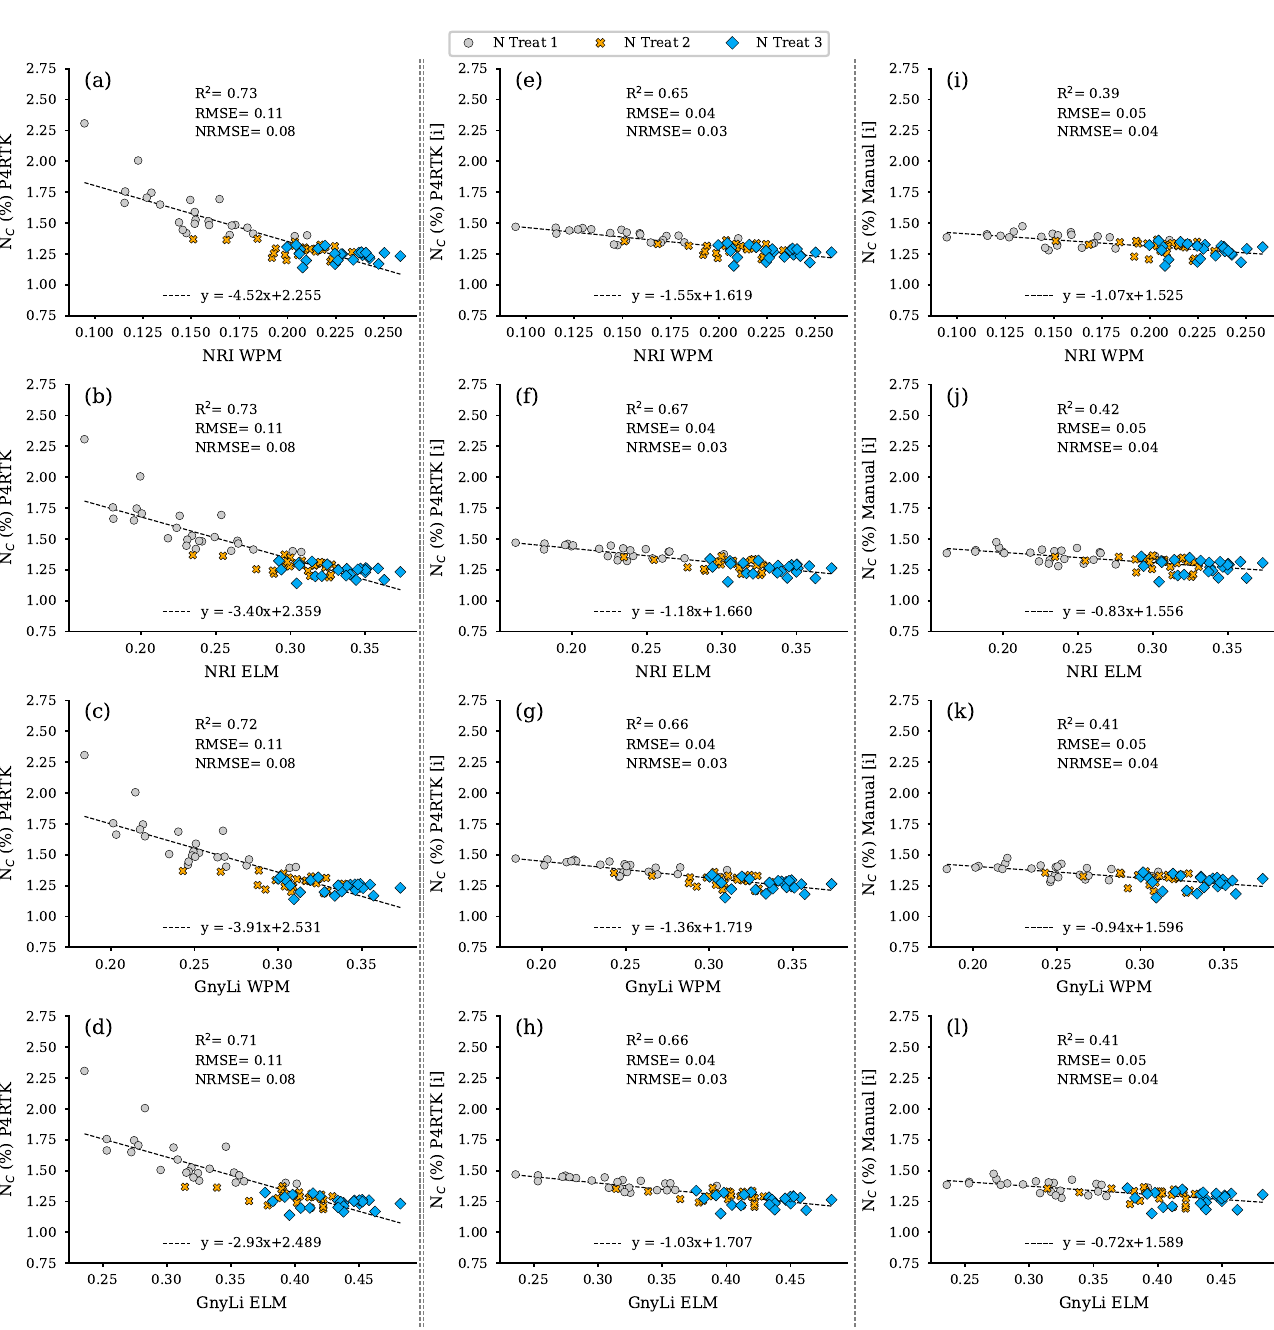
Figure 17. Scatter plots for the N concentration (N C ) data estimated for the 72 non-destructive test plots with the N C -model, based on the DBM estimator RM for three different CH data sets, with the spectral camera VIs acquired on 2 June. Left column: CH directly derived from P4RTK RGB data set of 2 June ( a – d ). Center column: linear interpolated CH from P4RTK RGB data set of 26 May and 12 June ( e – h ). Right column: linear interpolated CH manually measured on 26 May and 9 June ( i – l ). ( p < 0.001 for all regression